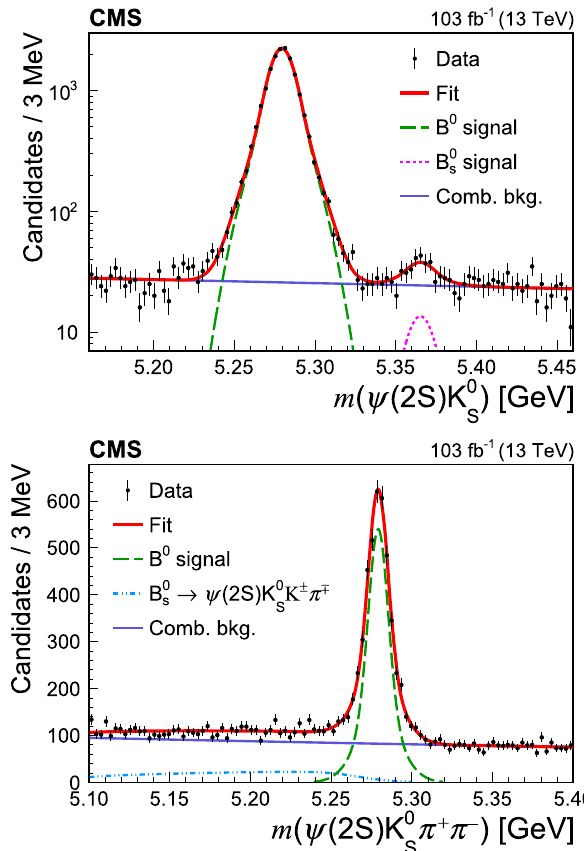
Fig. 1 Measured invariant mass distributions of ψ ( 2S ) K 0 S (upper) and ψ ( 2S ) K 0 π + π − (lower) candidates. The overlaid results from the fit are S described in the